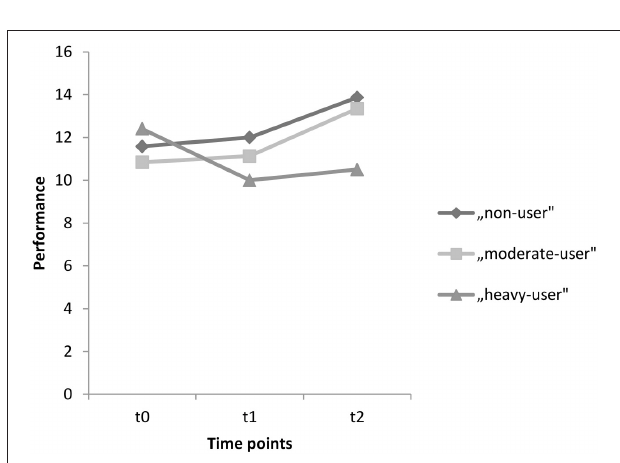
FIGURE 3 | Mean performances on the delayed recall test for time points t0, t1, and t2 for the groups, non-users, moderate-users, and